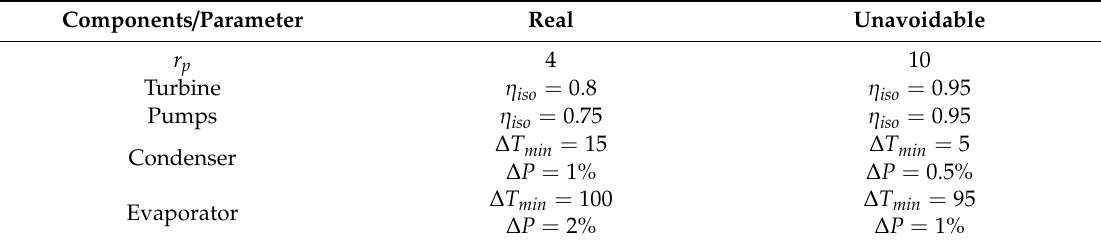
Table 7. Actual and unavoidable operating conditions for each component [37,38].